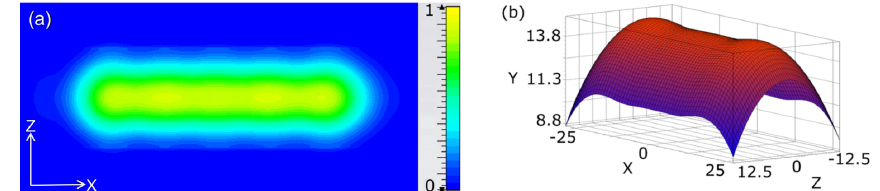
Figure 2. Microwave magnetic field distribution in open resonator. (a) The simulated microwave magnetic field distribution (normalized) at the plain mirror. The substrate flow is along the horizontal x direction. (b) The calculated shape of the concave mirror (scale is in mm).